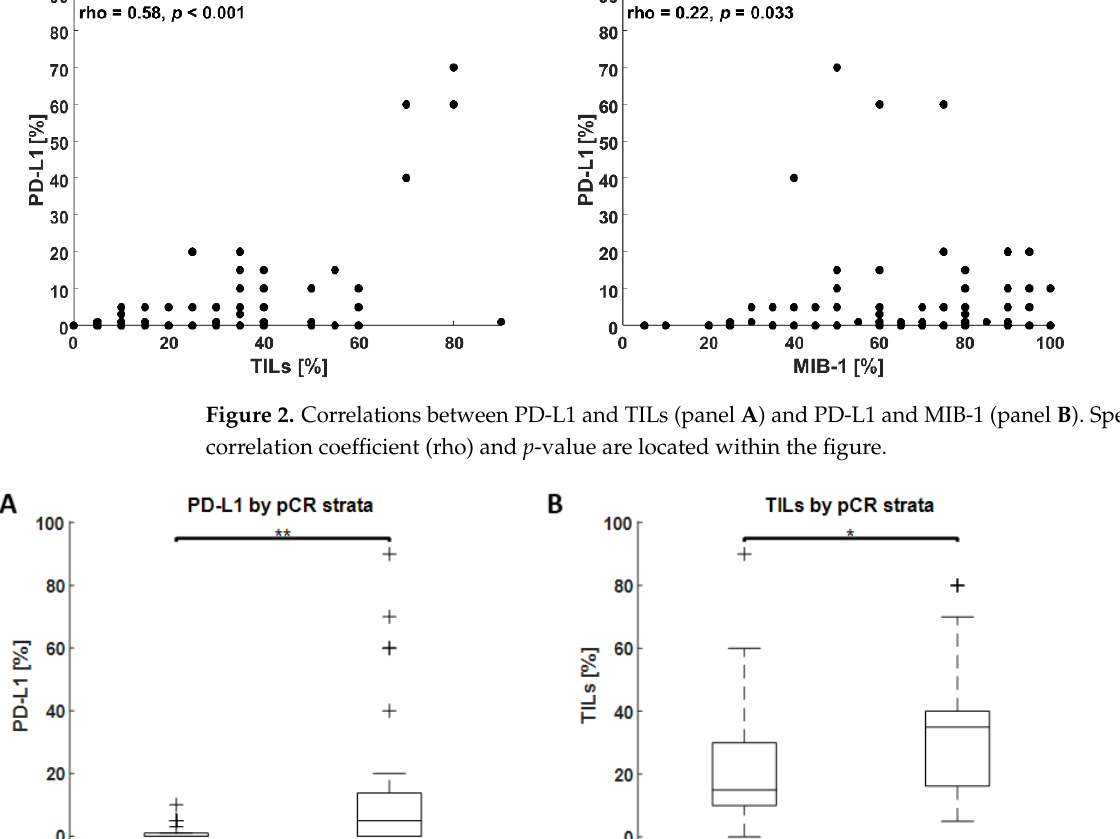
Figure 2. Correlations between PD-L1 and TILs (panel A ) and PD-L1 and MIB-1 (panel B ). Spearman correlation coefficient (rho) and p -value are located within the figure.